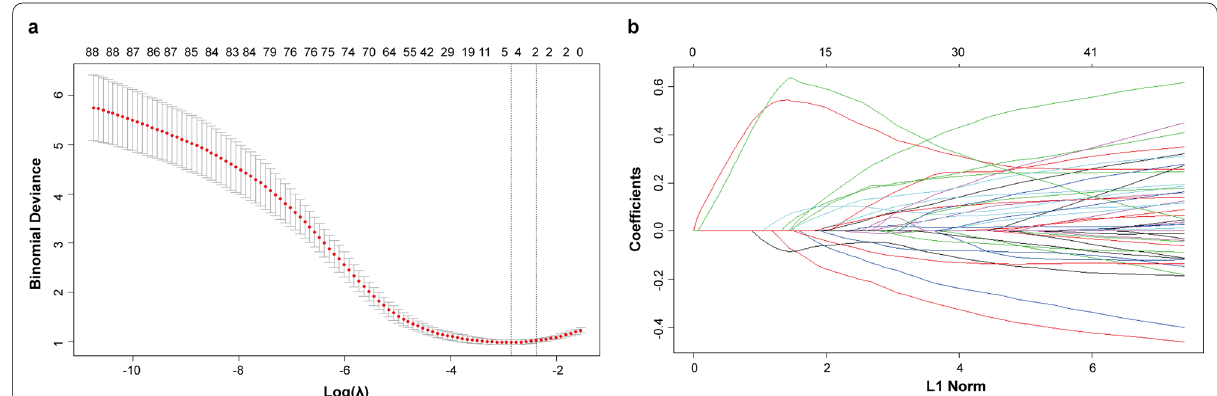
Fig. 2 Radiomics feature selection using the least absolute shrinkage and selection operator (LASSO) regression method. a The optimal λ was selected as the lowest binomial in the LASSO model using fivefold cross‑validation. b LASSO coefficient profiles of the features show vertical lines that are drawn at the value selected using fivefold cross‑validation, and the optimal λ results in 5 nonzero coefficients